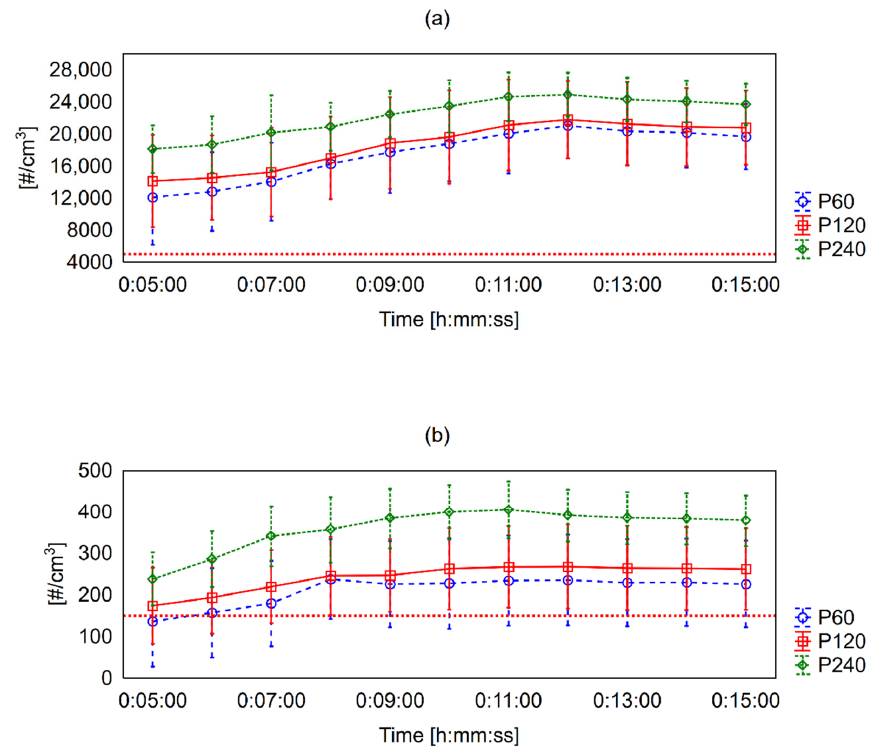
Figure 3. Comparison of mean (whisker: mean ± SD) total number concentration of particles during the sanding process (0:05:00–0:10:00) and residual sampling (until 0:15:00) for sanding grits P60, P120, and P240: ( a ) Time profile of measured data with NanoScan SMPS; ( b ) Time profile of measured data with OPS. Red dashed line represents upper background level.